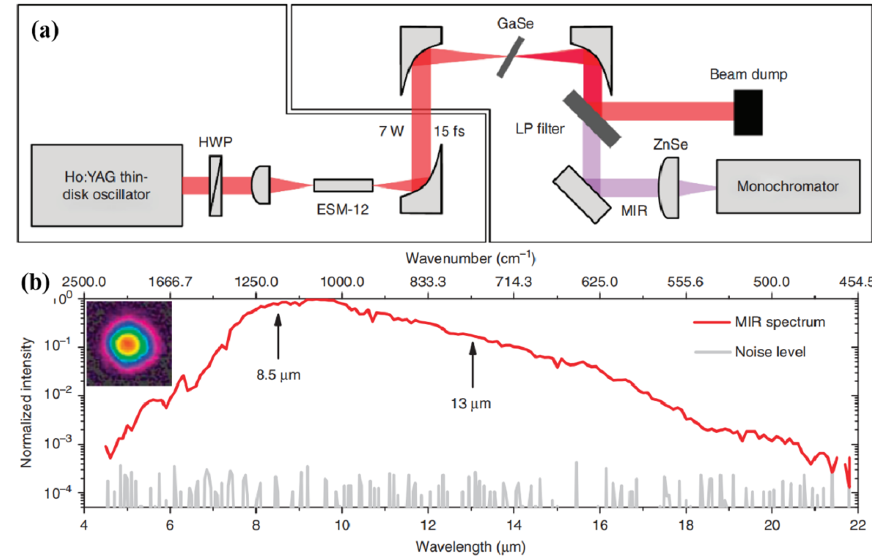
15 of 24 15 of 24